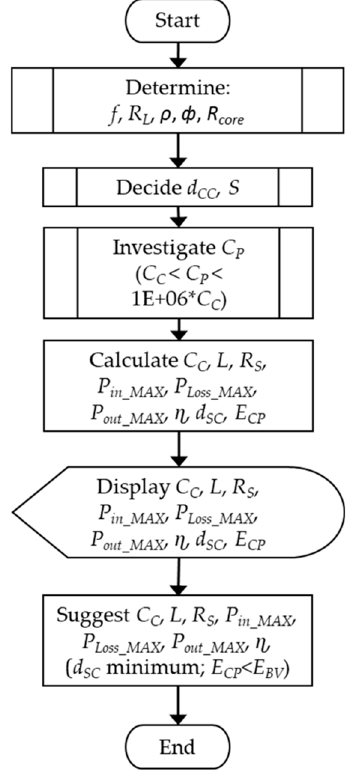
Figure 17. Design guidelines for optimizing the shielded-CPT system.